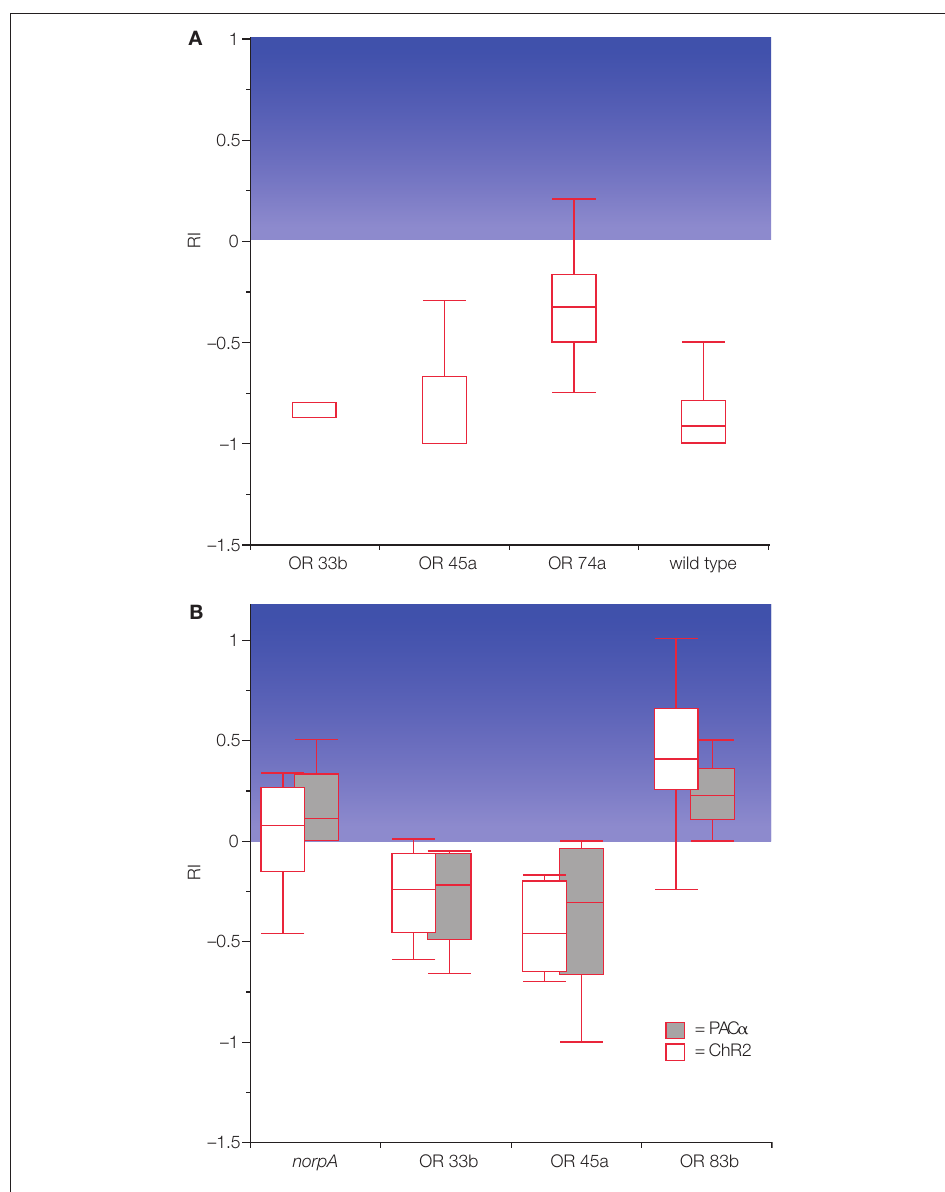
Figure 3 | Behavioral responses to blue light in the four-quadrant assay. The response index (RI) indicates the degree of attraction toward the blue illuminated areas of the Petri dish, illustrated by the blue background. (A) Wild type as well as larvae in which ChR2 is expressed in ORNs that endogenously express the receptors OR33b or OR45a strongly escape from the light. In contrast, when ChR2 is expressed in those ORNs that endogenously express the receptor OR74a larvae are significantly more attracted by blue light ( n = 20 each). (B) Blind larvae that express ChR2 or PAC α in all ORNs (OR83b) are attracted by blue light, while the expression of the same proteins in single ORNs with the endogenous receptors OR33b or OR45a results in an avoidance of the light. The blind mutant control ( norpA ) shows no preference ( n = 10 each; modified from Bellmann et al., 2010).The median is indicated as line in the box. Boxes locate the 25 and 75 percentiles and the whiskers indicate the minimum and maximum